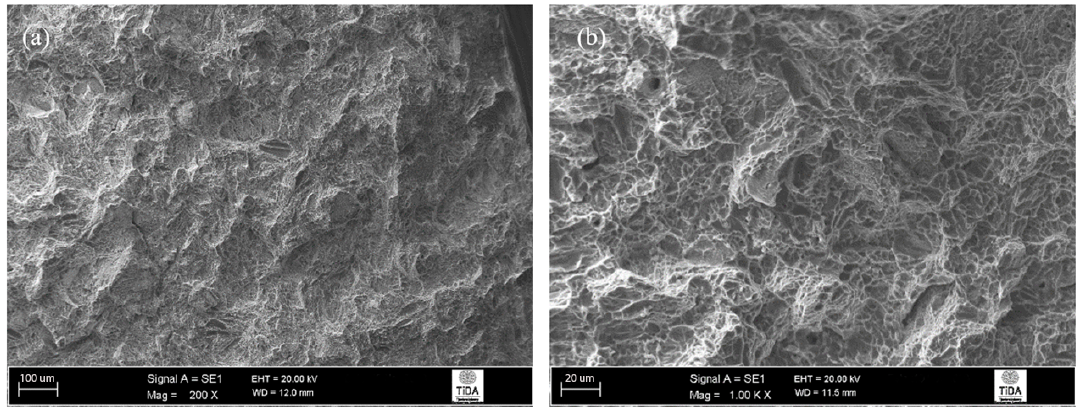
Figure 11. Fracture surface of 955 °C/1 h, FC heat-treated Ti-6Al-4V alloy: ( a ) general appearance; ( b ) evidence of ductile fracture.